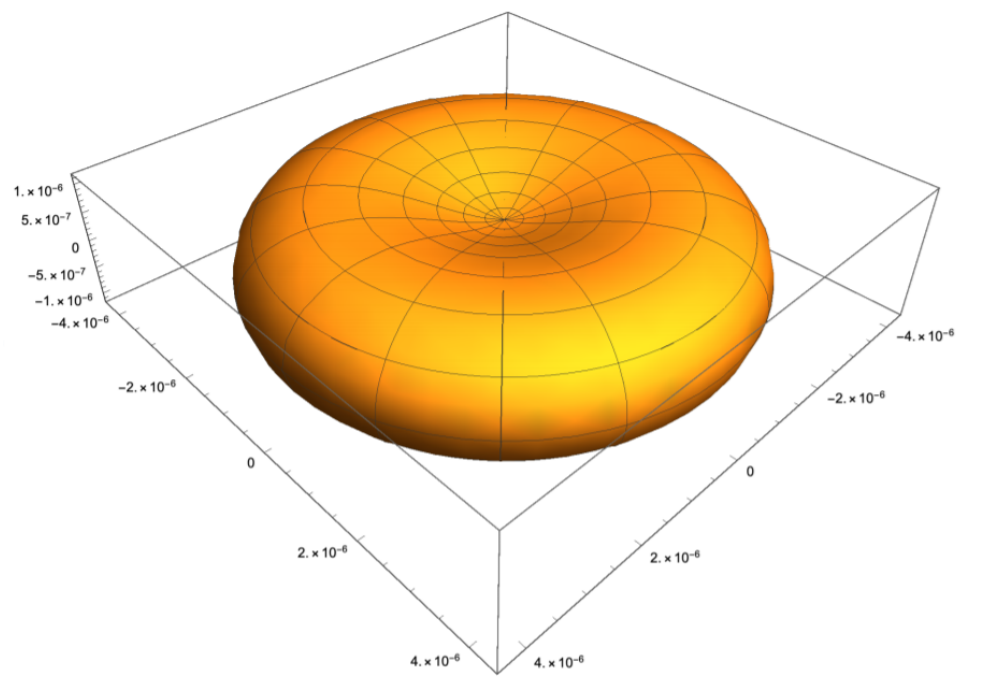
Figure 3. A representative illustration of an